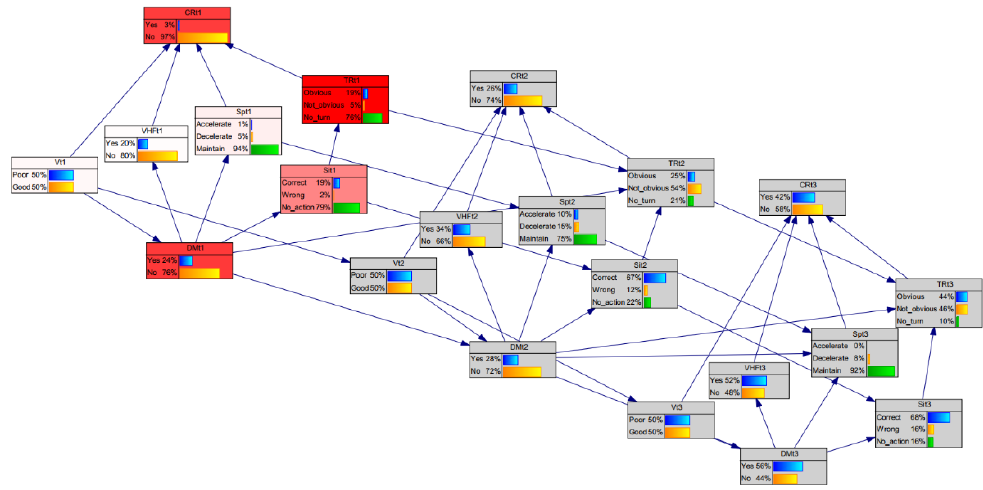
Figure 8. Node influence degree under the low collision risk (CRt 1 ) in the DBN model.